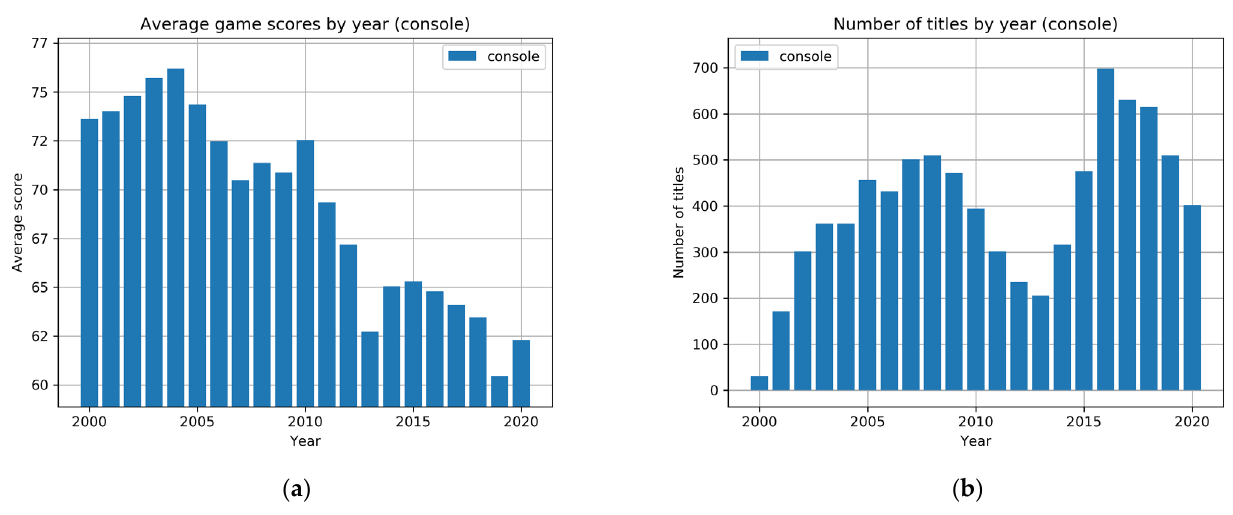
Figure 3. Evaluation of console games statistics over time; ( a ) average user scores by year; ( b ) number of new releases by year.